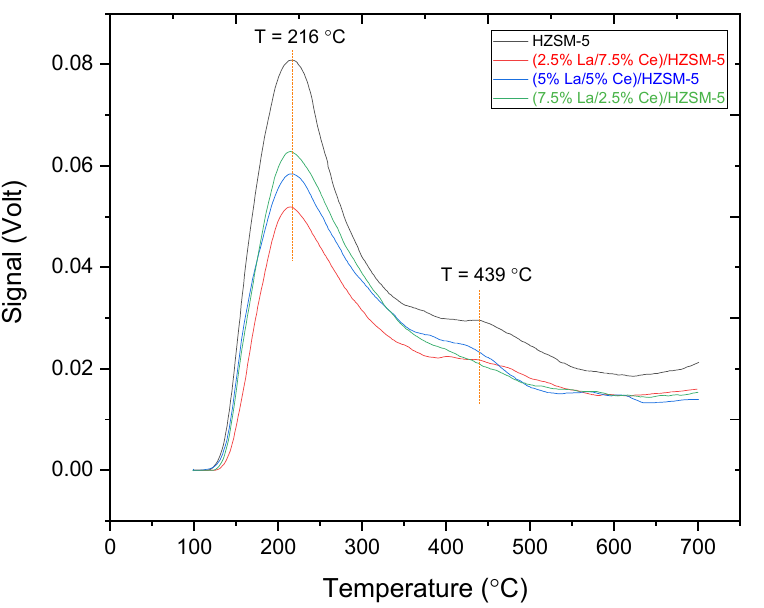
Figure 8. NH 3 -TPD profiles of the parent HZSM-5 and Lanthanum-Cerium modified catalysts: (2.5%La-7.5%Ce)/HZSM-5, (5%La-5%Ce)/HZSM-5, and (7.5%La-2.5%Ce)/HZSM-5.